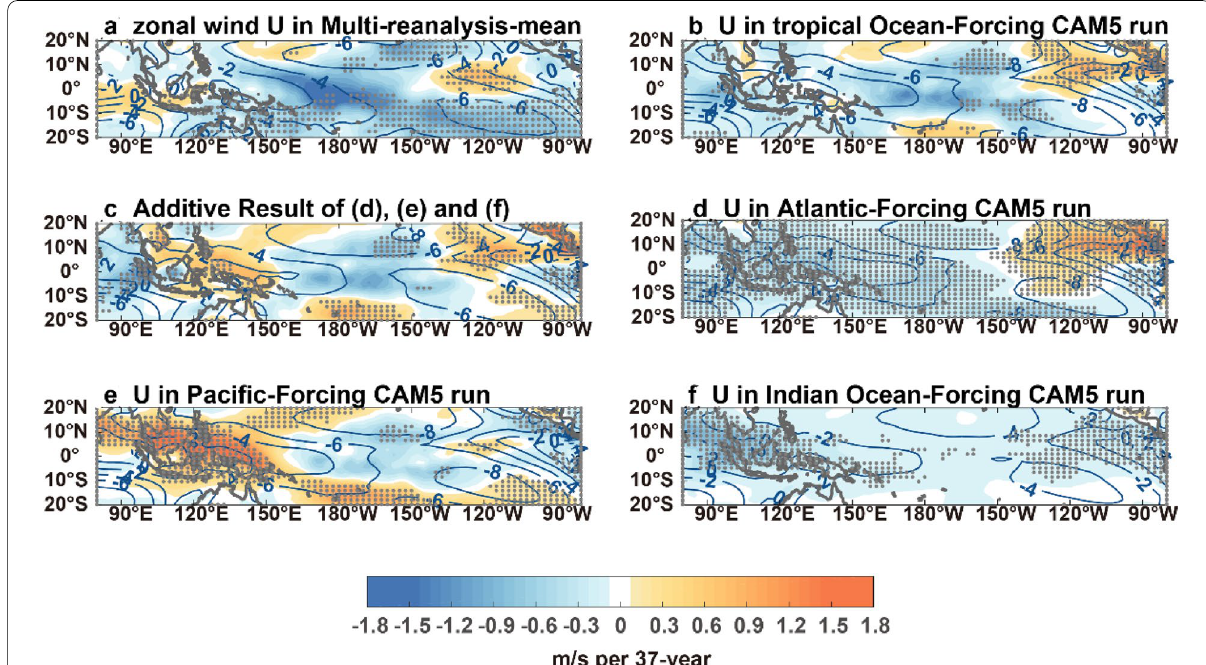
Fig. 3 The observed and simulated trends of the surface zonal wind over the tropical Pacific. a Shows the surface zonal wind climatology (contours) and its trend (color) from 1979 to 2015 in the ensemble‑mean of six reanalysis datasets. The gray dots represent the areas with confidence level of 95%. b Shows the simulated zonal wind trend in the pan‑tropical‑ocean forcing atmospheric model experiments, with d – f showing the simulated zonal wind trends in the tropical Atlantic‑, the tropical Pacific‑, and the Indian Ocean‑forcing experiments. c Shows the sum of results in d – f , which is very similar to the model results driven by the pan‑tropical‑oceans ( b ), implying the linearity between the SST forcings from different tropical ocean